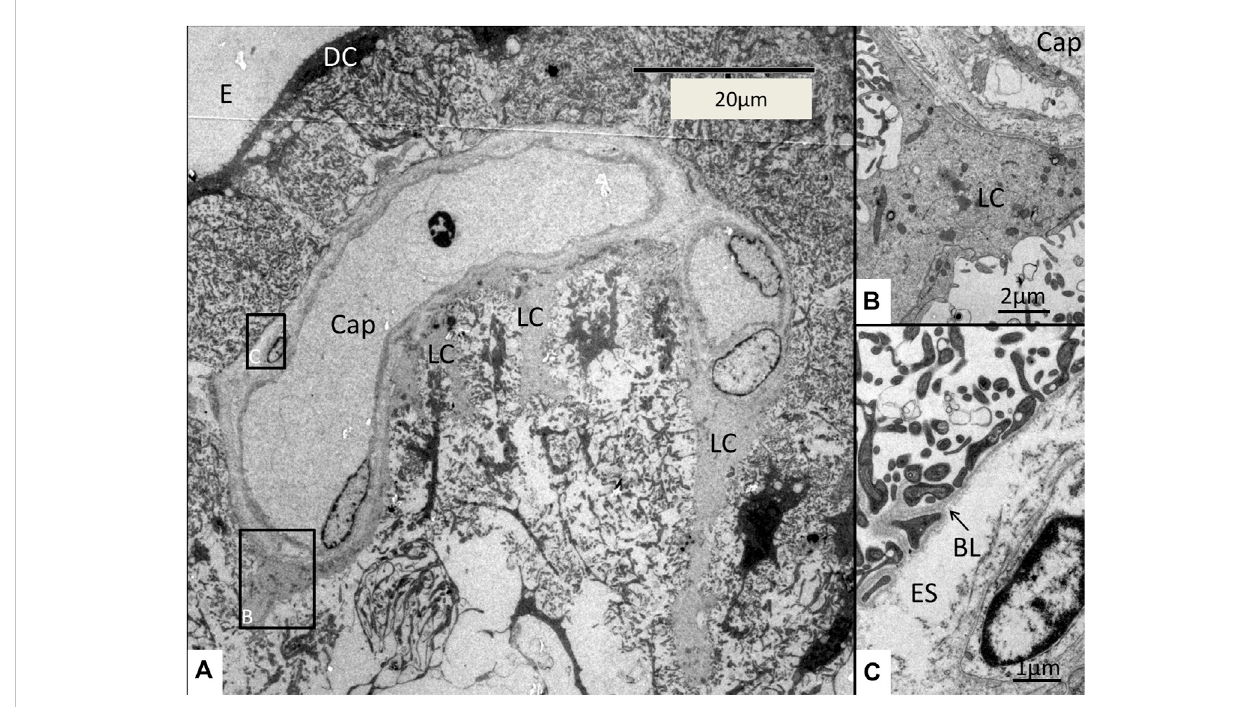
FIGURE 9 A strial capillary (cap) located near the endolymph space (E). Framed areas are magni fi ed in (B,C) . The vessel is partly surrounded by light cells (LC). (B) Framedareain (A) ismagni fi edandshowsalightcelltightlyadjoiningthecapillarywalladheringtothebasallamina. (C) Framedareain (A) ismagni fi edshowing the extensive basal enfoldings of the DCs adhering to the basal lamina (BL) around the pericapillary extra-cellular space (ES). DC, dark cell; E,